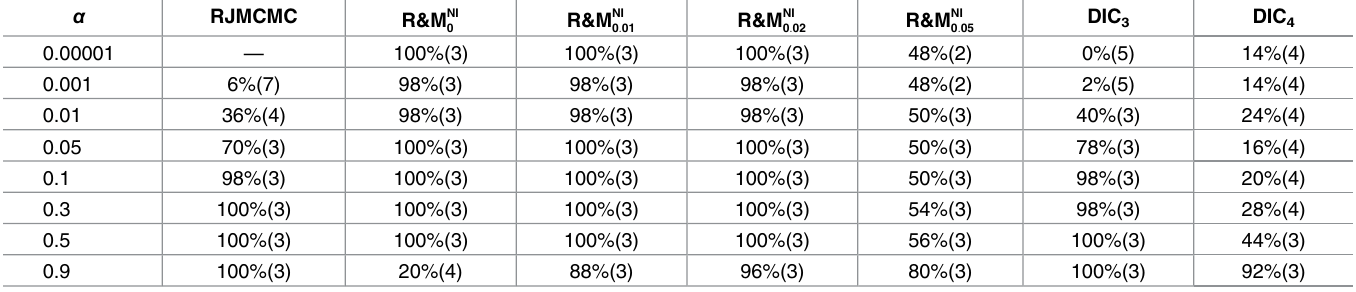
Table 3. Unequal proportions heterogeneous scenario; a heterogeneous population with three clusters. λ 1 = 0.475, λ 2 = 0.475, λ 3 = 0.05, μ 1 = 1, μ 2 = 2, μ 3 = 3 and σ 1 = σ 2 = σ 3 = 0.25 (high separation). Percentage of data sets in which the true numberof clusters was found, with the mode of the estimated number of classes in parentheses.